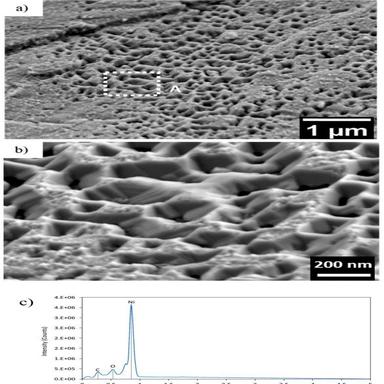
SE images of the fracture surface of a specimen exposed to the solution containing 10,000 ppm of PbO. (a) Geometrical facets on a TG fracture surface of a grain at low magnification; (b) 3D pyramidal structure of the pores from area A and (c) 5 kV SEM-EDX spectrum extracted from the region.